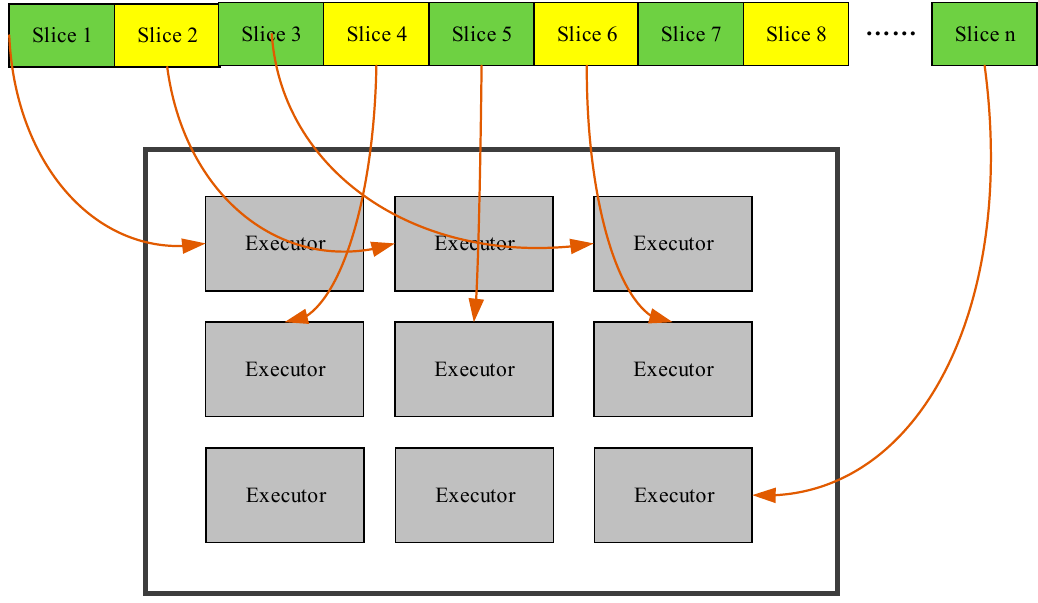
Figure 9. Local clustering calculation stage.